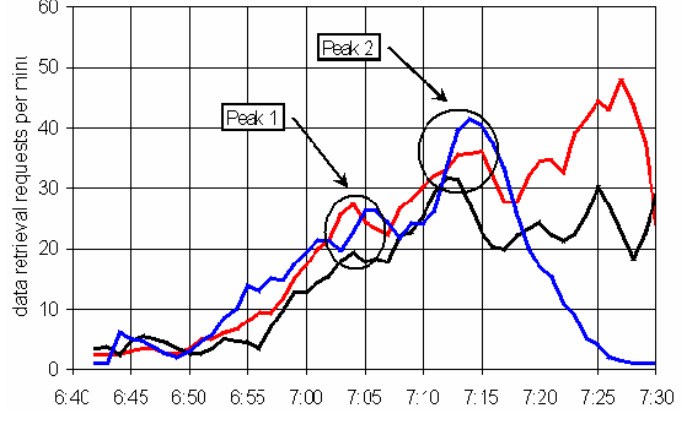
Figure 11a. Sept 12-26 (After 7:15 the curves reflect the beginning of that week's activity. The activity for the week with the blue line was to go to their respective breakout groups and to discuss content